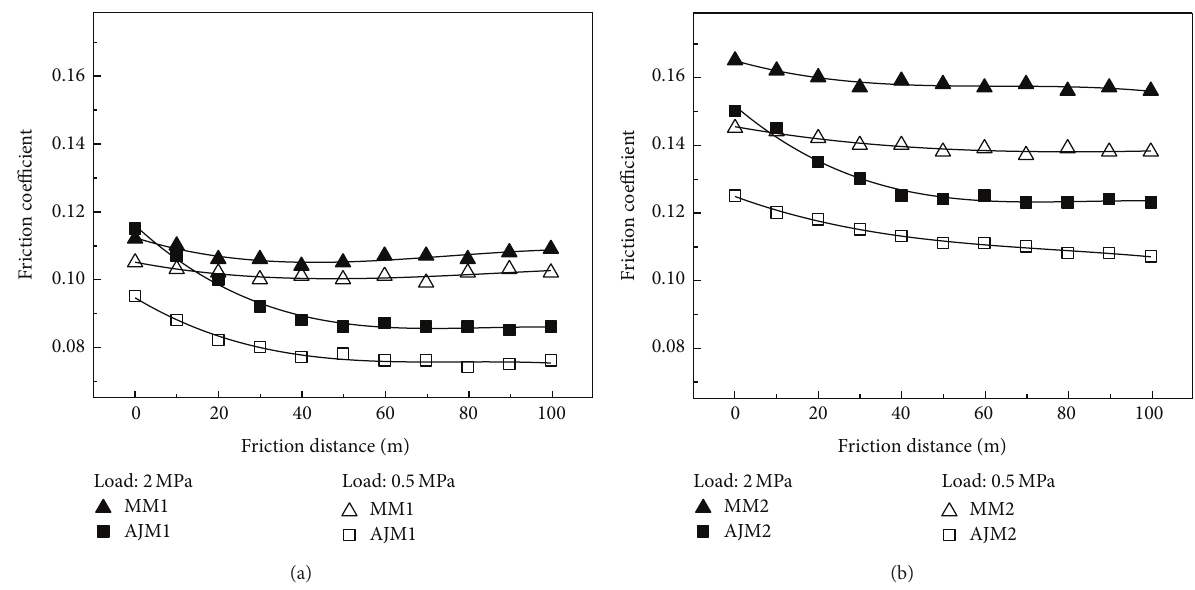
Figure 5: Relationship between different loads and friction